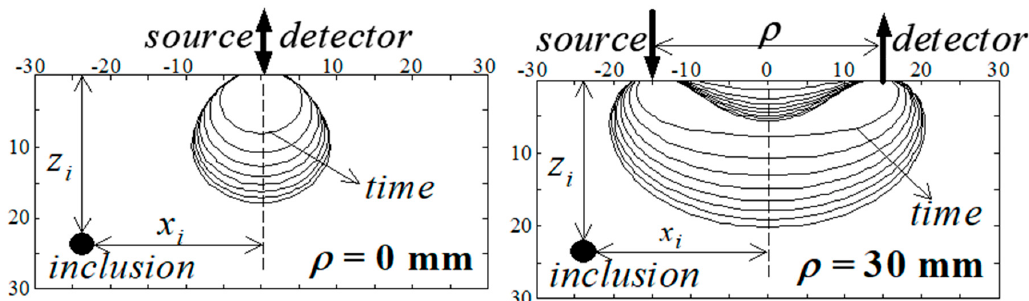
Figure 3. The depth sensitivity of a TD reflectance measurements to localized optical perturbations is dependent on the photon arrival time and independent of ρ . The limiting case of ρ = 0 corresponds to the most spatially confined sensitivity map (modified from [38]). The contour lines correspond to time ranging from 0.5 to 4 ns at steps of 0.5 ns.